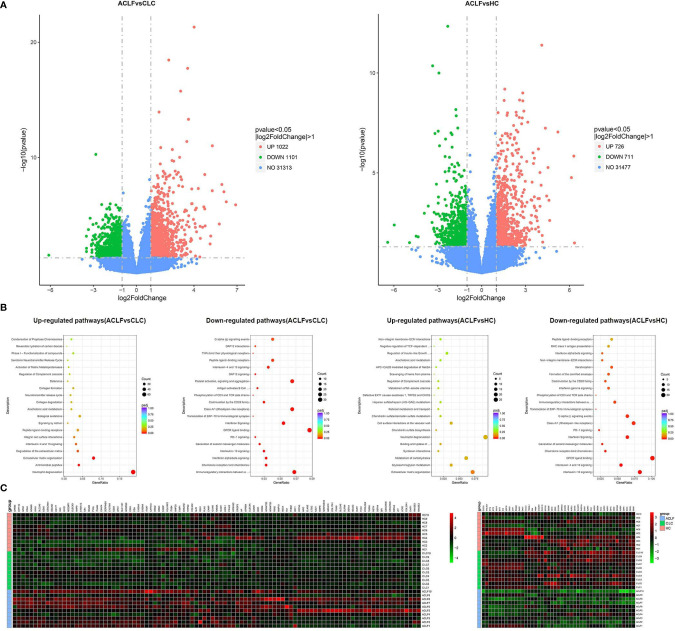
Neutrophil transcriptomics in hepatitis B virus related acute-on-chronic liver failure (HBV-ACLF) patients. (A) The volcano graph showed differentially expressed genes of neutrophils between patients with HBV-ACLF (N=10) and compensated liver cirrhosis (CLC) (N=10) or healthy controls (HCs) (N=10). Red indicates up-regulation of expression, and green indicates down-regulation of expression. (B) Reactome analysis showed that down-regulated and up-regulated pathways between patients with HBV-ACLF (N=10) and CLC (N=10) or HCs (N=10). (C) Heatmap representations of the most down-regulated and up-regulated genes in ACLF-neutrophils compared to CLC-neutrophils; Red indicates up-regulation of expression, and green indicates down-regulation of expression.